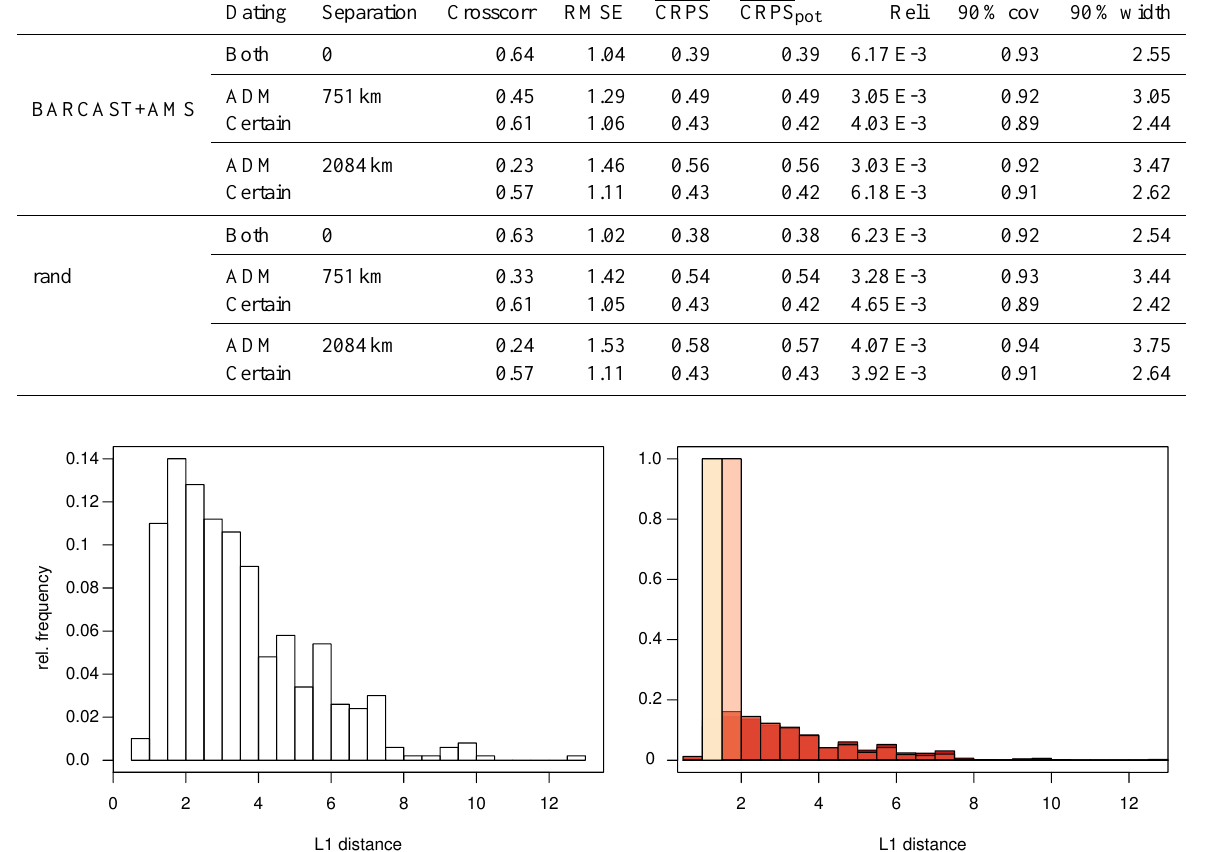
Figure 3. Left panel: distribution of all available ADMs by L1 distance. Right panel: distribution of drawn ADMs with heated chains without state swapping. The beige (dark red) corresponds to the coolest (hottest) chain. Results are for the two-proxy experiment (Sect. 4.1) with intermediate spatial